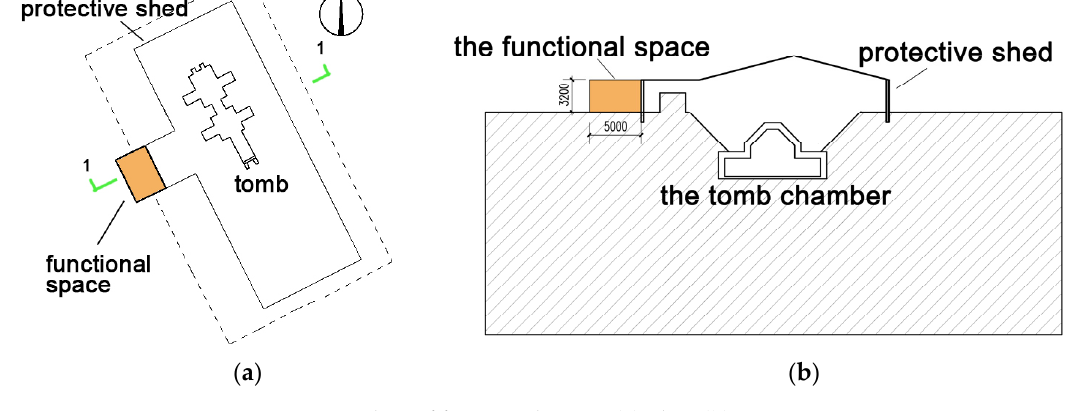
Figure 8. Outline of functional space: ( a ) Plan; ( b ) Section 1-1.